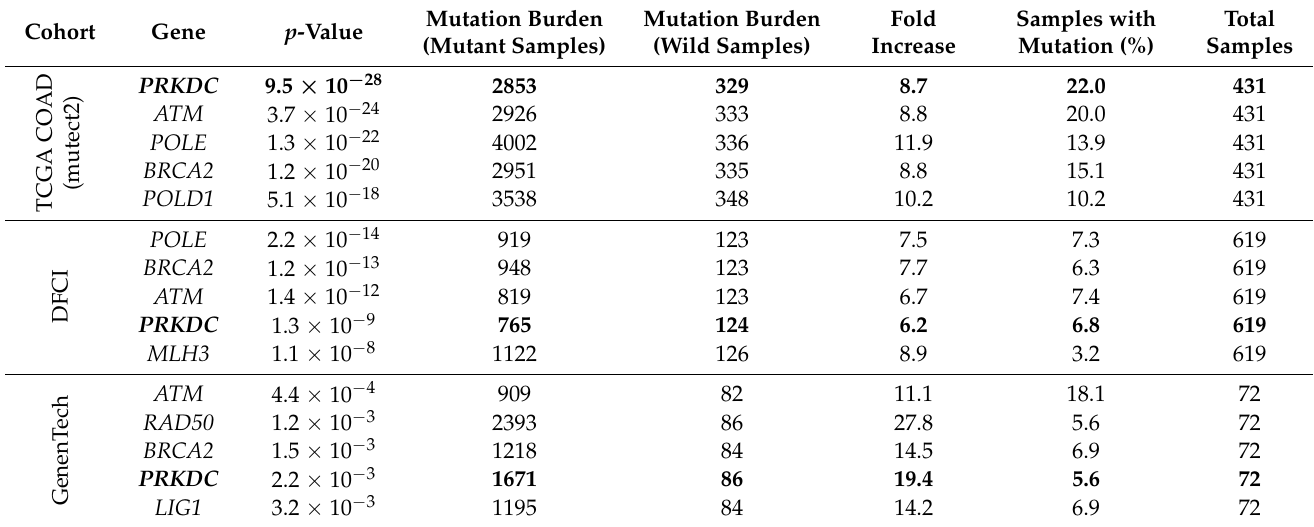
Table 1. Top genes associated with high mutation burden in colorectal